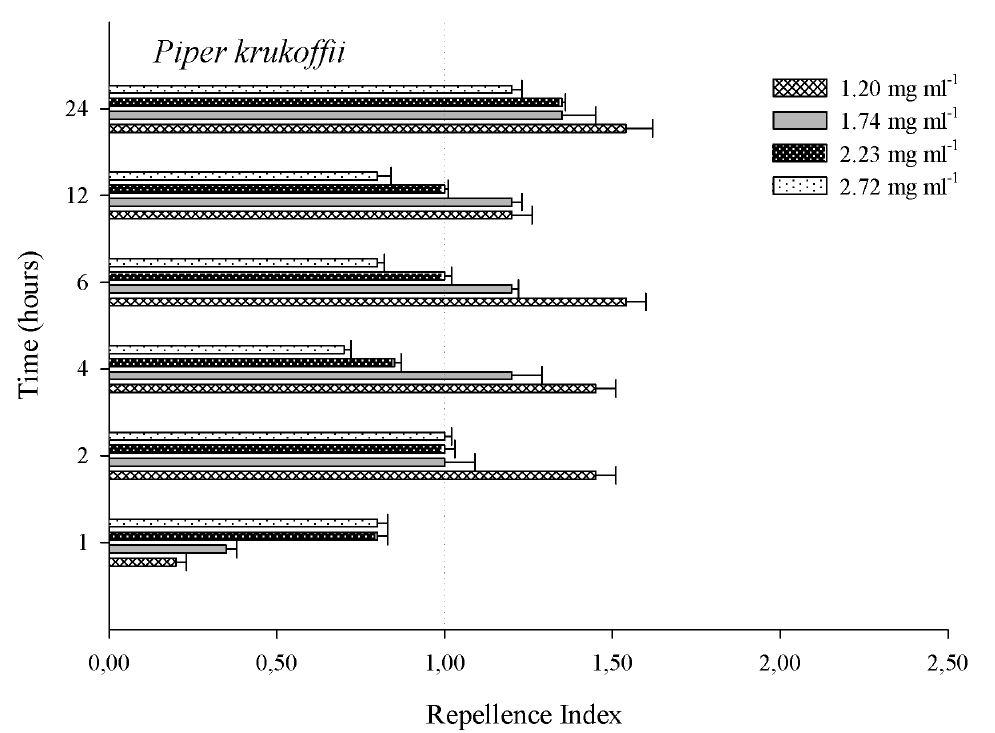
Figure 2. P. xylostella larval repellency after exposure to P. krukoffii oil for 24 h